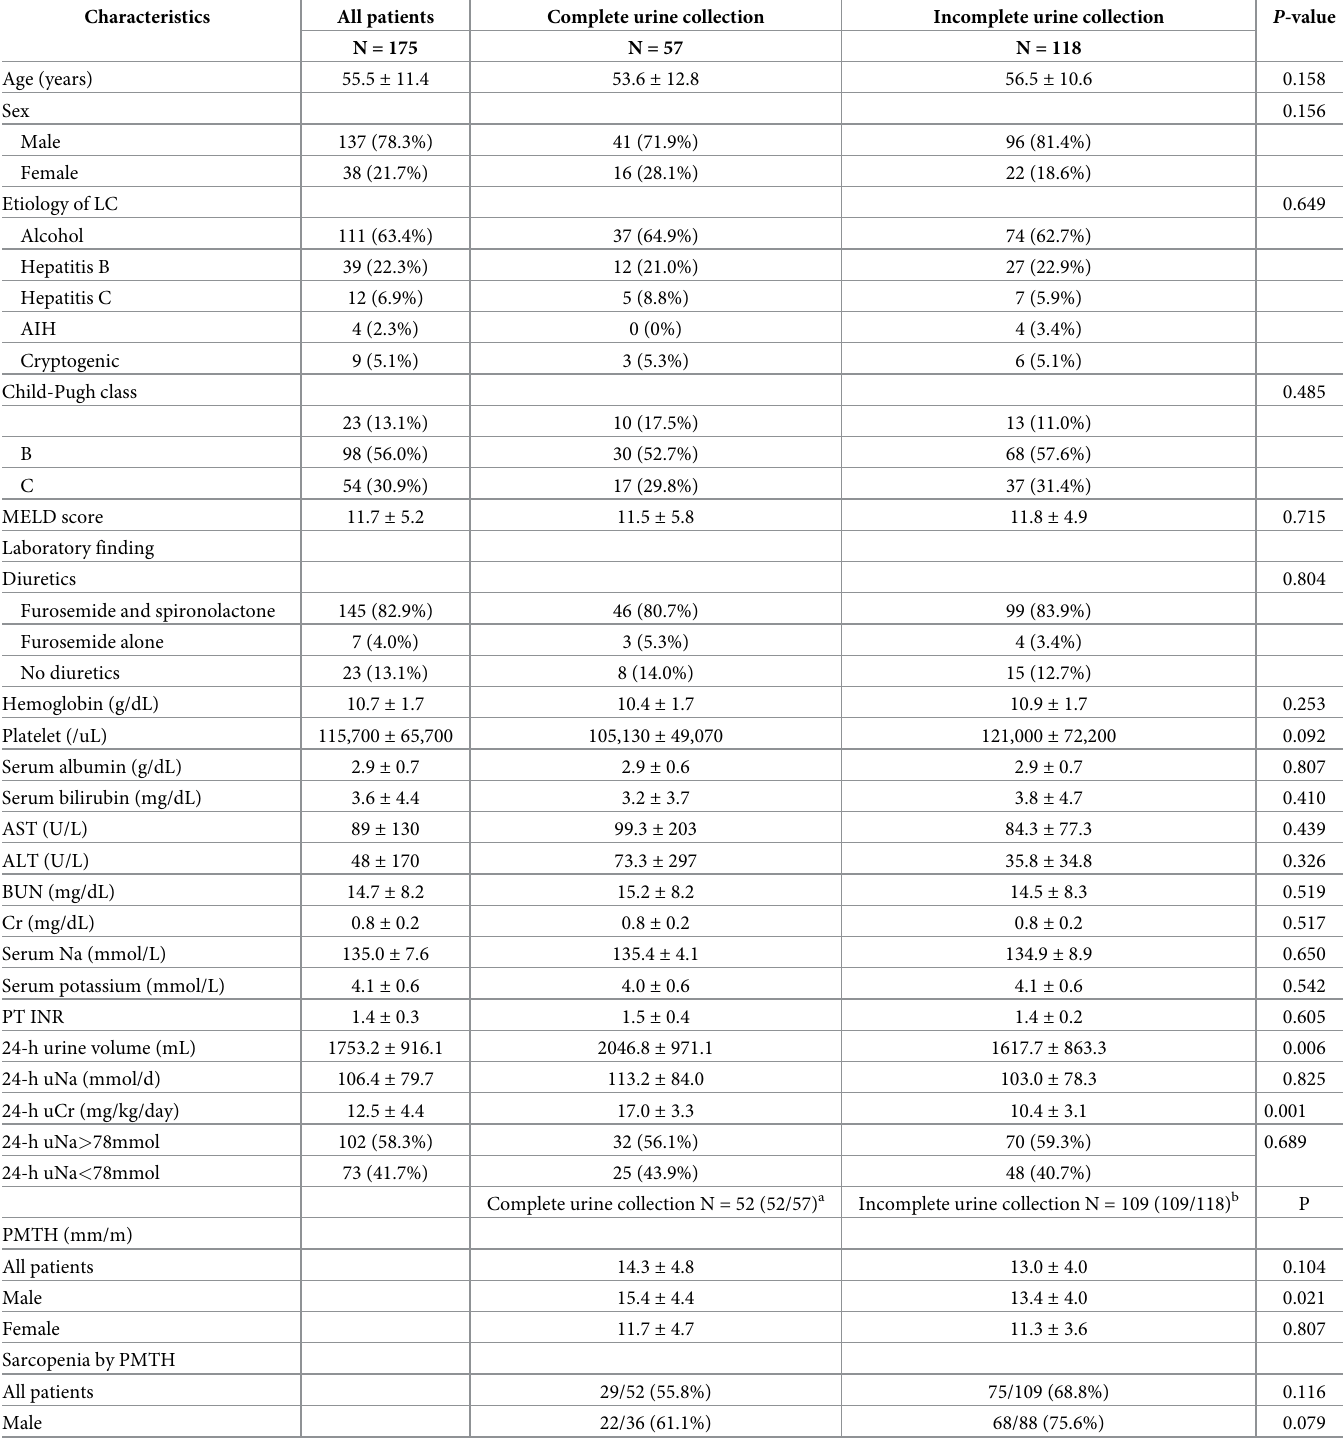
Table 1. Patients’ clinical characteristics and laboratory test